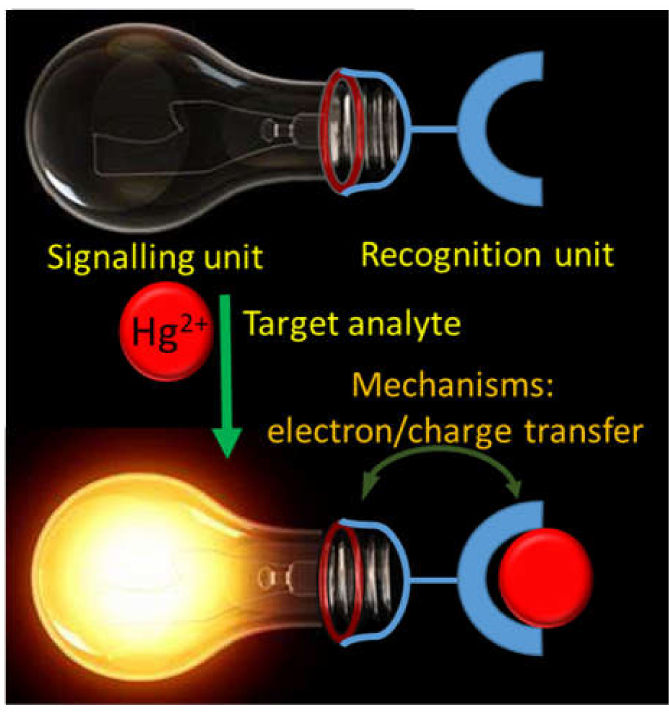
Figure 1. Schematic representation showing the design of a